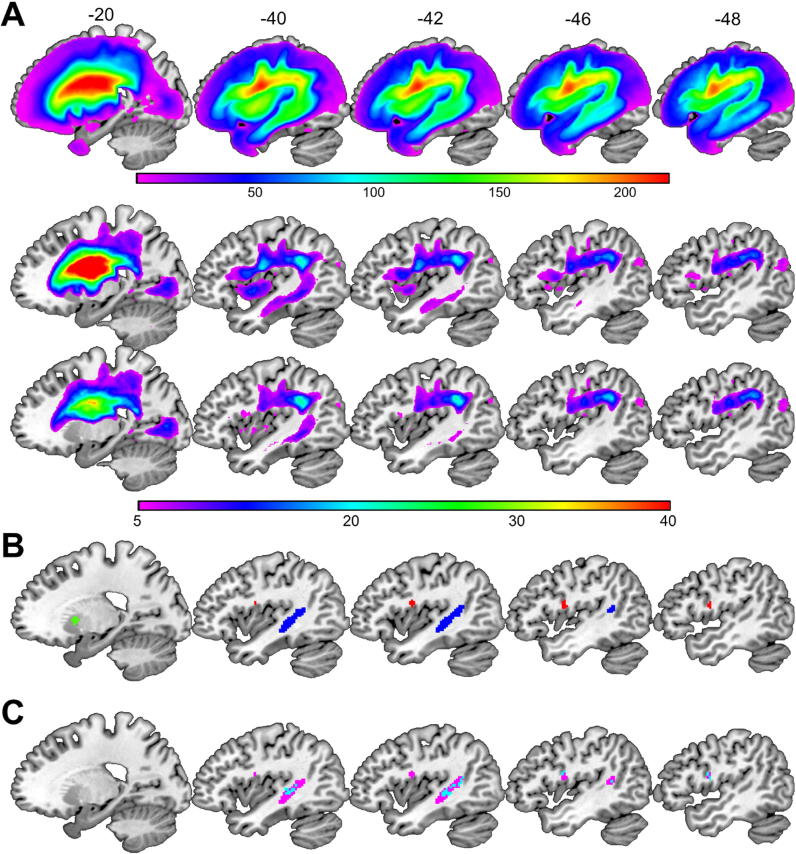
Lesion overlap maps and regions identified in Analyses 1 and 2. (A) From top to bottom, the lesion overlap maps for Analysis 1 (n = 359), Analysis 2 (n = 127) and Analysis 3 (n = 114) are shown in sagittal slices. The colour scale indicates the number of patients with overlapping lesions at each given voxel. (B) The regions identified in Analysis 1 (with fuzzy images) are highlighted in blue (the temporal region) and red (the frontal region). The region identified in Analysis 2 (the putamen) is highlighted in green. The temporal and frontal regions are thresholded at p < 0.05 FWE-corrected. The putamen region is thresholded at p < 0.001 uncorrected for visualization purposes only. (C) The significant lesion-deficit associations identified in Analysis 1 using the: (i) fuzzy lesion images are shown in pink; (ii) binary lesion images are shown in blue. Cyan is the overlap. (For interpretation of the references to color in this figure legend, the reader is referred to the web version of this article.).